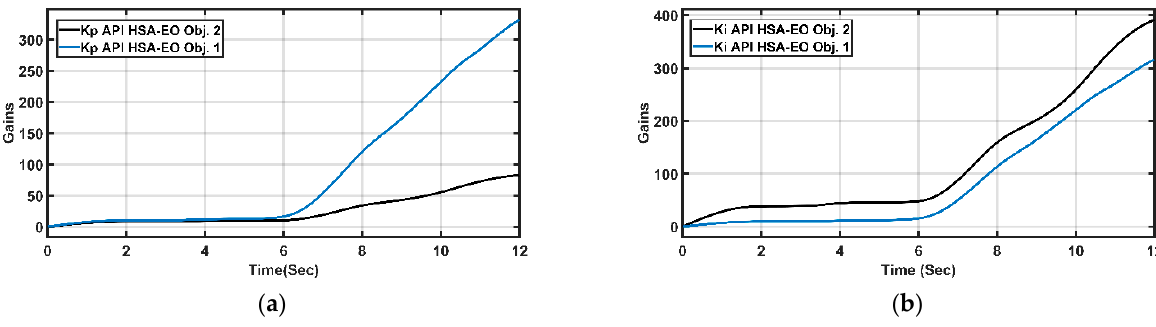
Figure 33. ( a ) (cid:1837) (cid:3043) adaptive PI gain of faulty third case. ( b ) (cid:1837) (cid:3036) adaptive PI gain of faulty third case. Table 15. Numerical comparison between the controllers at faulty third case. Table 16. Statistical analysis of the active power—faulty third case.